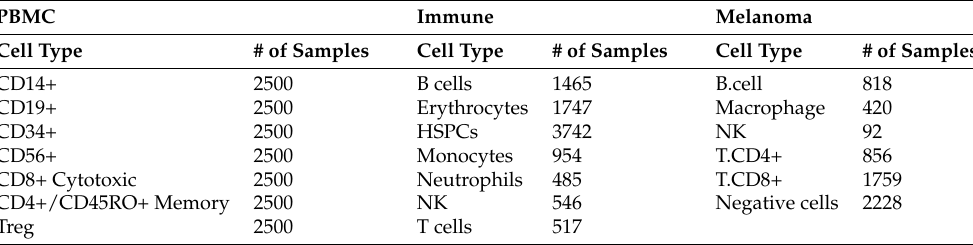
Table 1. Cell type distribution for each